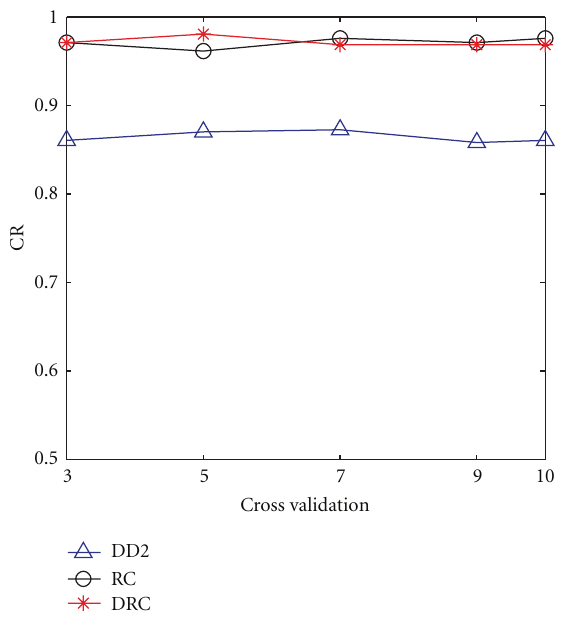
Figure 5: Summary classification performance using n -fold cross validation (the x -axis is for varying n